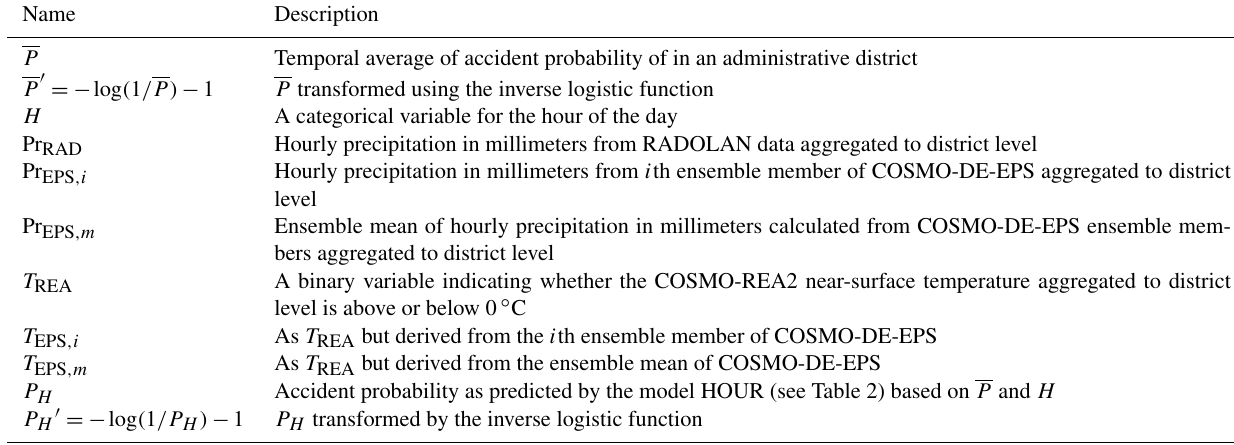
Table 1. Descriptions of predictor variables used in different logistic regression models for hourly probabilities of weather-related road accidents in German administrative districts.